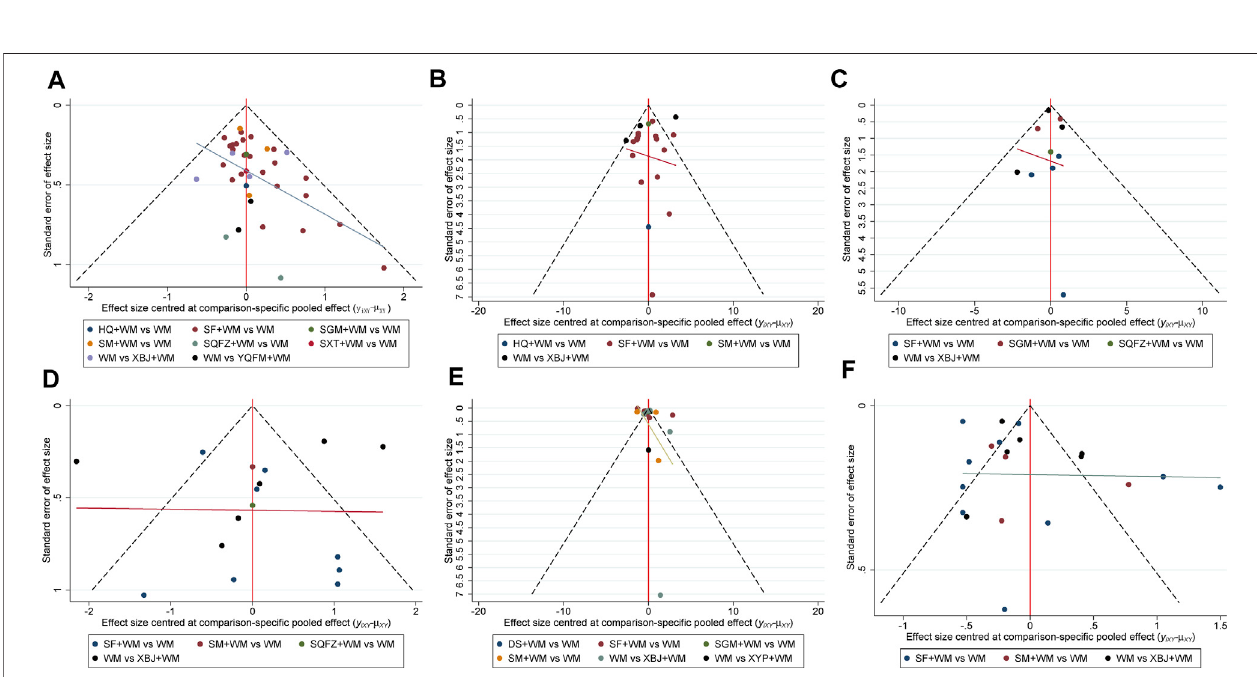
FIGURE6 | Funnel plots (A) 28-days-motality (B) ICU length ofstay (C) Hospital length of stay (D) SOFA score at day 7after interventions (E) Procalcitonin level at day 7 after interventions (F) Serum lactate level at day 7 after interventions; WM, Western Medicine; SF, Shenfu injection; SM, Shenmai injection; SGM, Shengmai injection; XBJ, Xuebijing injection; YQFM, Yiqifumai injection; DS, Danshen injection; HQ, Huangqi injection; SXT, Shuxuetong injection; SQFZ, Shenqifuzheng injection; XYP, Xiyanping injection.